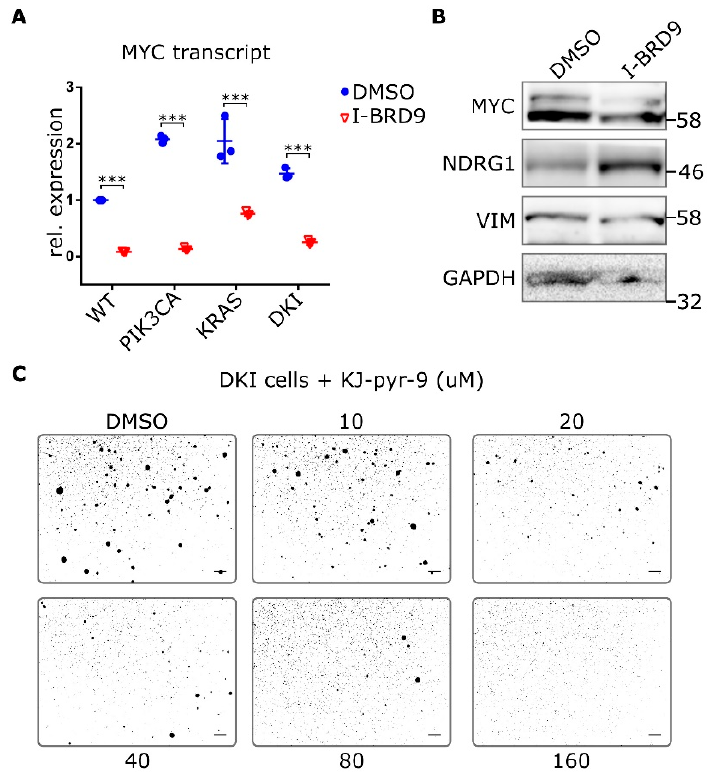
Figure 6. Inhibition of MYC blocks anchorage-independent growth in double mutant cells. ( A ) RT-qPCR data (Mean ± SD) showing MYC expression in MCF-10A WT and mutant cells after 24 h incubation with 20 µ M I-BRD9. ( B ) Protein levels of MYC and target NDRG1 as well as VIM in DKI cells after 24 h treatment with 20 µ M I-BRD9. ( C ) Soft agar growth of DKI cells in the presence of the MYC inhibitor KJ-Pyr-9 for 15 days. ***, p < 0.001 (unpaired t-test); scale bars = 100 μ m.